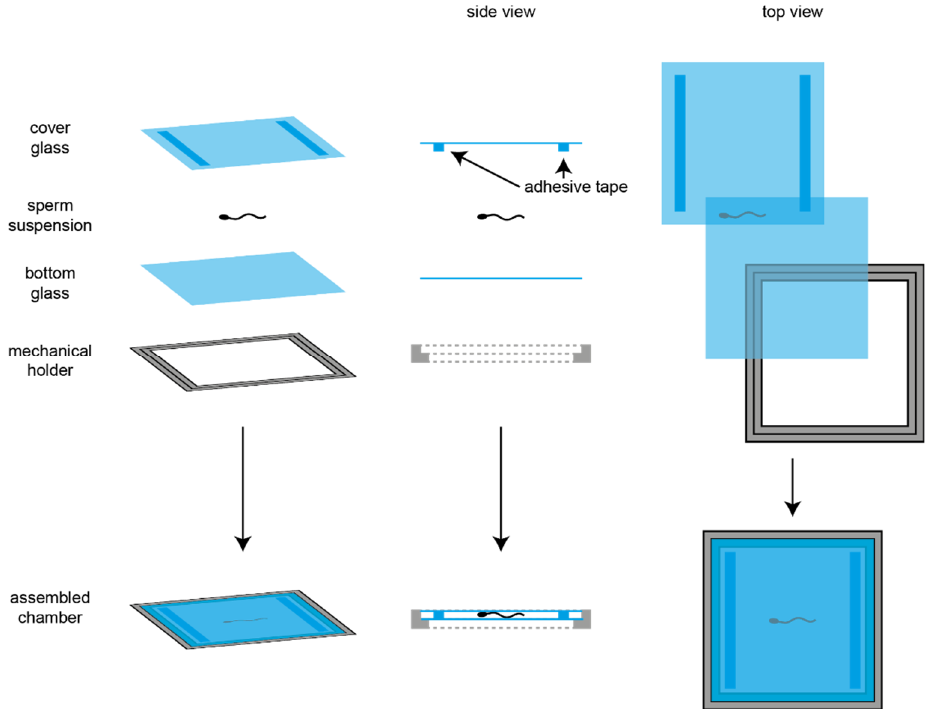
Figure 1. Custom-made observation chamber. The observation chamber was produced by a custom-made mechanical holder (metal), in which a glass cover slip was placed. Next, a drop of sperm in suspension was placed in the center of the cover slip. Then, another cover slip was placed on top, to which two piles of each three layers of adhesive tape (Tesafilm ® , Tesa, Norderstedt, Germany) were placed, so that a chamber depth of 150 µm was generated (depth was measured).